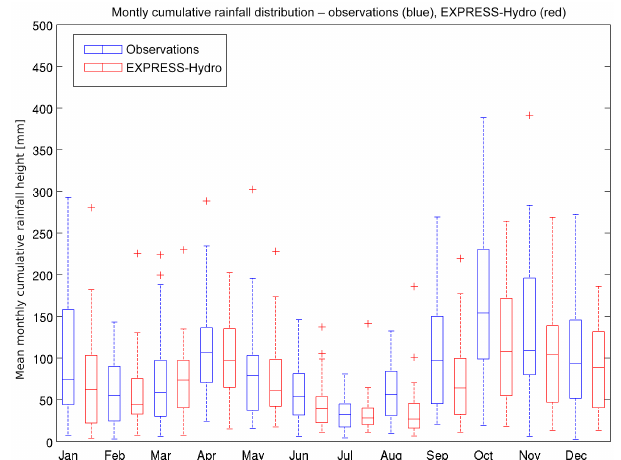
Figure 5. Box plot of monthly precipitation averaged at the regional scale. Blue box plots are built with observations while red ones are built with the EXPRESS-Hydro